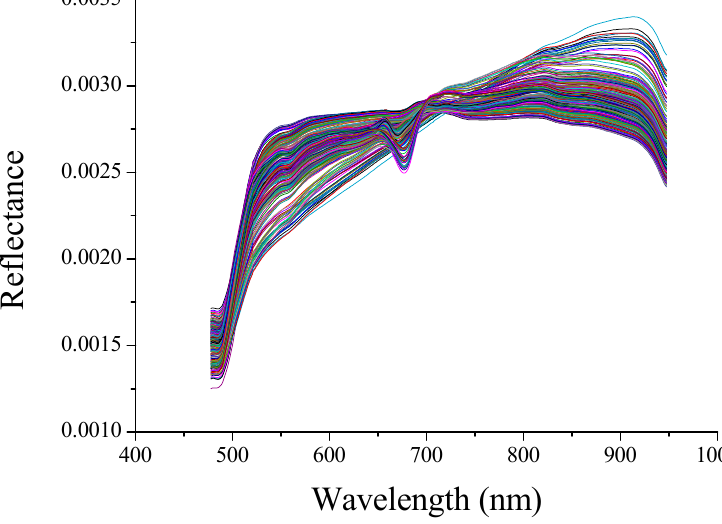
Figure 1. Reflectance spectra of fresh-cut potato tuber slices.